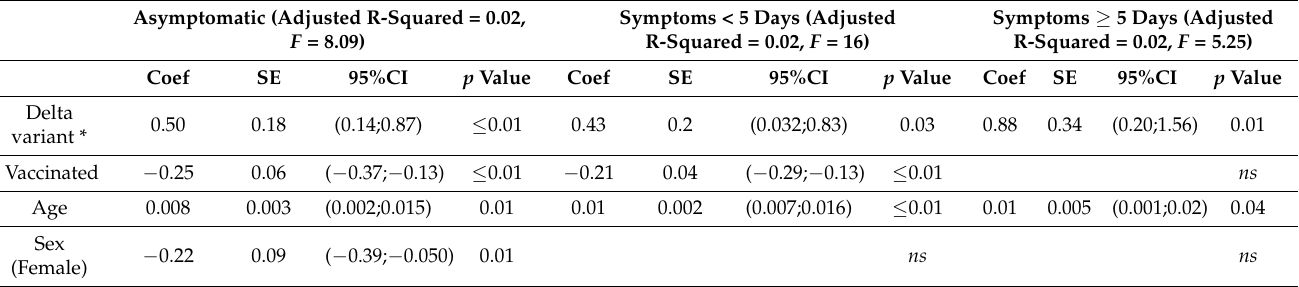
Table 4. Multivariate analysis of the nasopharyngeal viral load stratified on symptoms (final analysis). Asymptomatic (Adjusted R-Squared = 0.02, F =